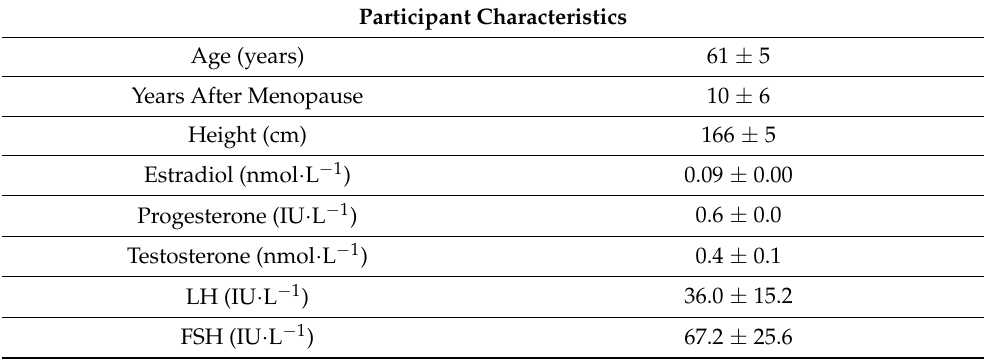
Table 1. Baseline characteristics of the study participants ( n = 13).